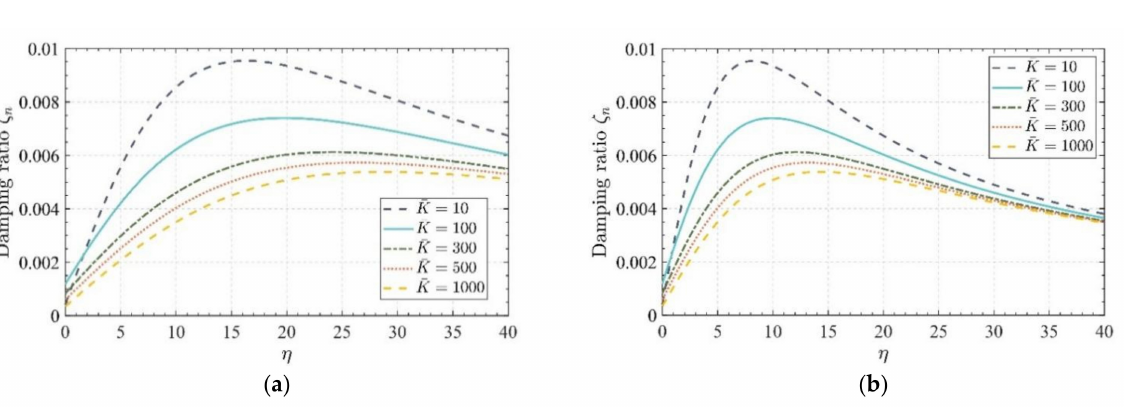
Figure 4. Impact of stiffness of the internal rubber damper on cable modal damping with k s = 0, ϕ = 0.5, x 1 / L = 0.01, x 2 / L = 0.02 and: ( a ) n = 1; ( b ) n =